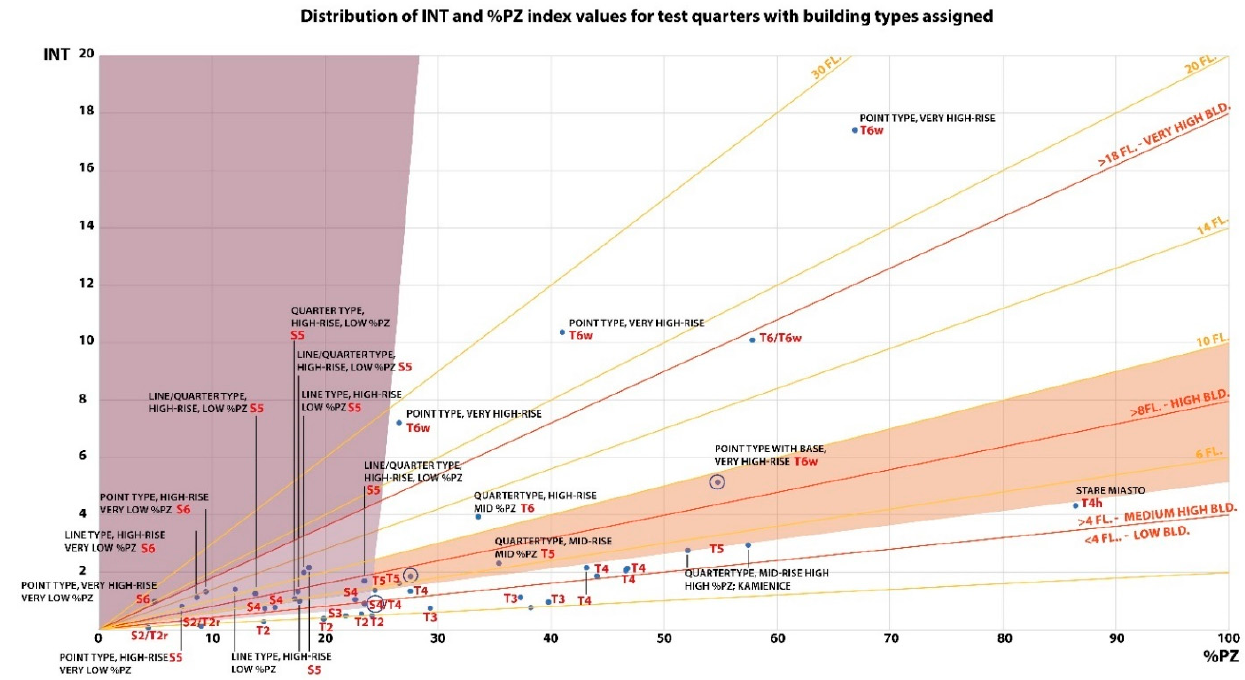
Figure 7. Distribution of INT and %PZ index values for test quarters with building types assigned. Source: own study.